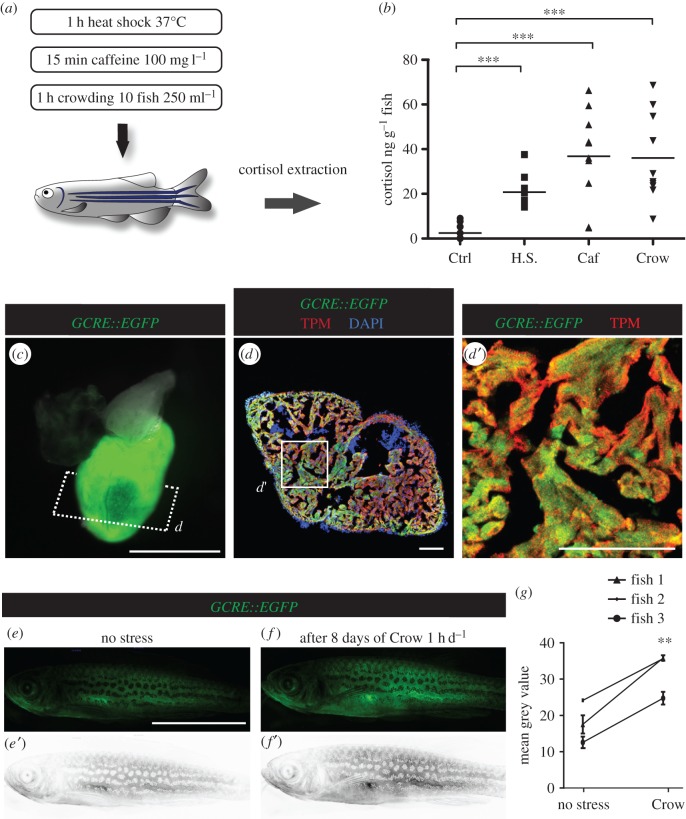
In adult zebrafish, stress stimulates cortisol secretion and activates GCR signalling. (a) Adult zebrafish were exposed to different stressors. (b) Whole-body cortisol levels are shown as a dot plot. Each dot represents the value obtained for one fish. The dash indicates the mean value of each group (N ≥ 10 fish; ***p < 0.001). H.S., heat shock; Caf, caffeine, Crow, crowding. (c) Live heart dissected from Tg(GCRE::EGFP) fish display GFP in the ventricle. (d,d′) Immunofluorescence analysis of Tg(GCRE::EGFP) heart section demonstrates a colocalization between tropomyosin and GFP. However, this transgenic reporter is not ubiquitously expressed in adult tissues. (e,f) Fluorescent images of the same transgenic animal Tg(GCRE::EGFP) reveal an enhanced glucocorticoid receptor (GCR) transcriptional activity in the whole body at 8 days after 1 h of daily crowding, as compared to the state before stress. (e′,f′) Converted images of the GFP signal into a grey scale using Image J software for quantification of fluorescence. (g) Graph showing the mean converted fluorescence values obtained for three different fish before and after the period with daily acute stress exposure. **p < 0.01. Scale bars: (c) 1 mm, (d) 100 µm and (e) 10 mm.